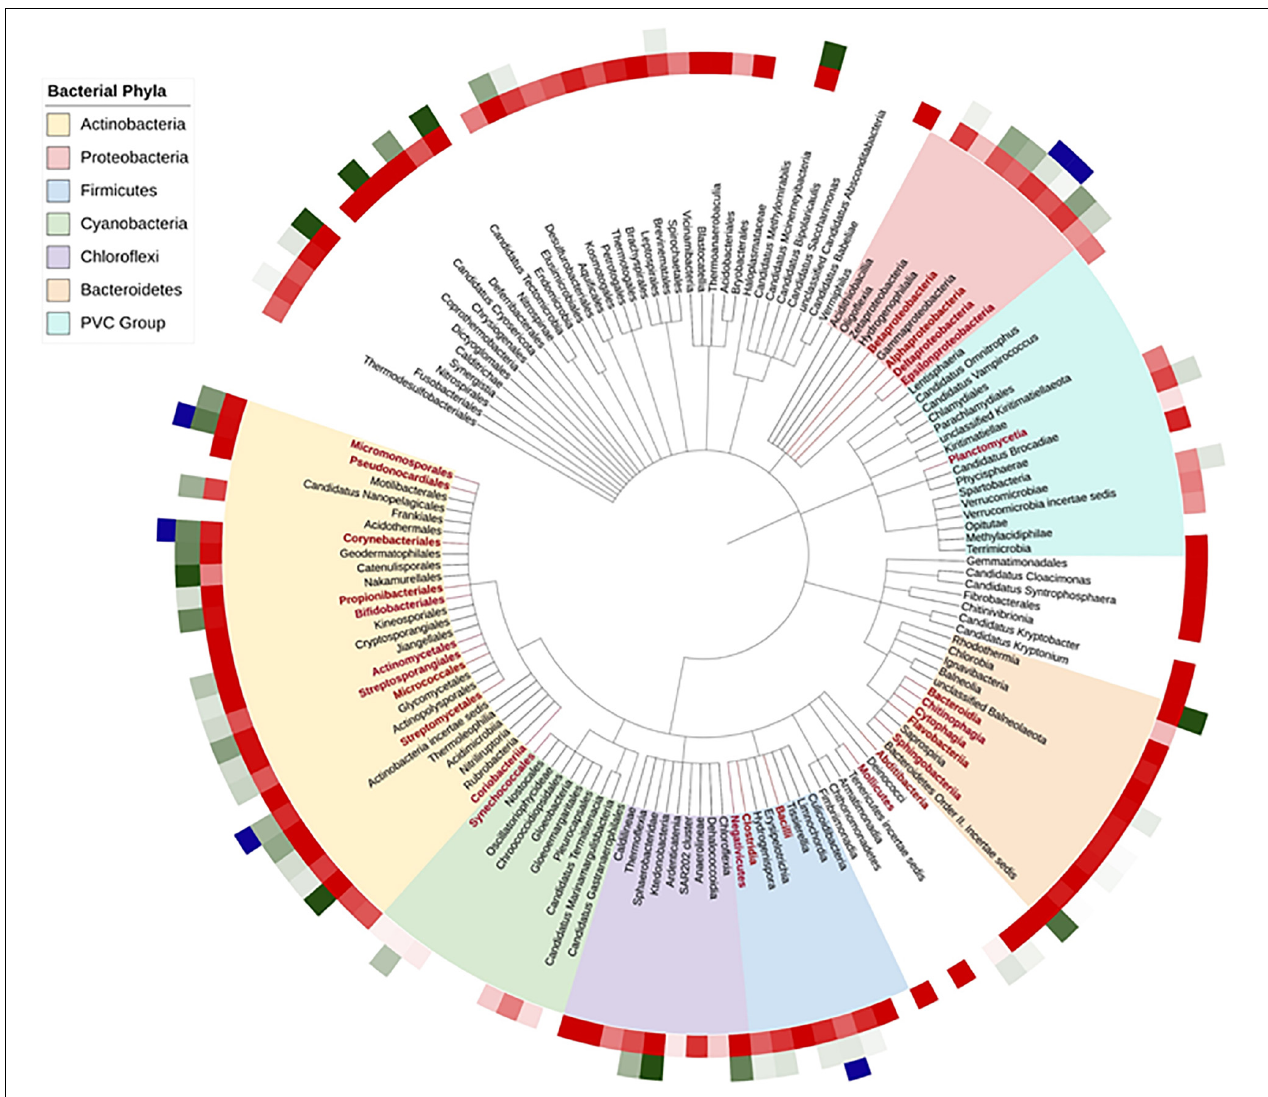
FIGURE 2 | Sirtuins by bacterial class taxon. Bacterial classes are shown on a bacterial Tree of Life (Generated with PhyloT). Only those classes with more than 10 species genomes annotated in Uniprot are shown; those with more than 50 genomes are shown with branch and label in red. Bacterial phyla are indicated in the onset legend. The first layer indicates, in a red darkness gradient, the abundance of sirtuin-containing species per class. The second layer, in a green darkness gradient, indicates the abundance of species containing more than one sirtuin. The third layer indicates the classes with species that possess sirtuins that have been shown to regulate some substrate in